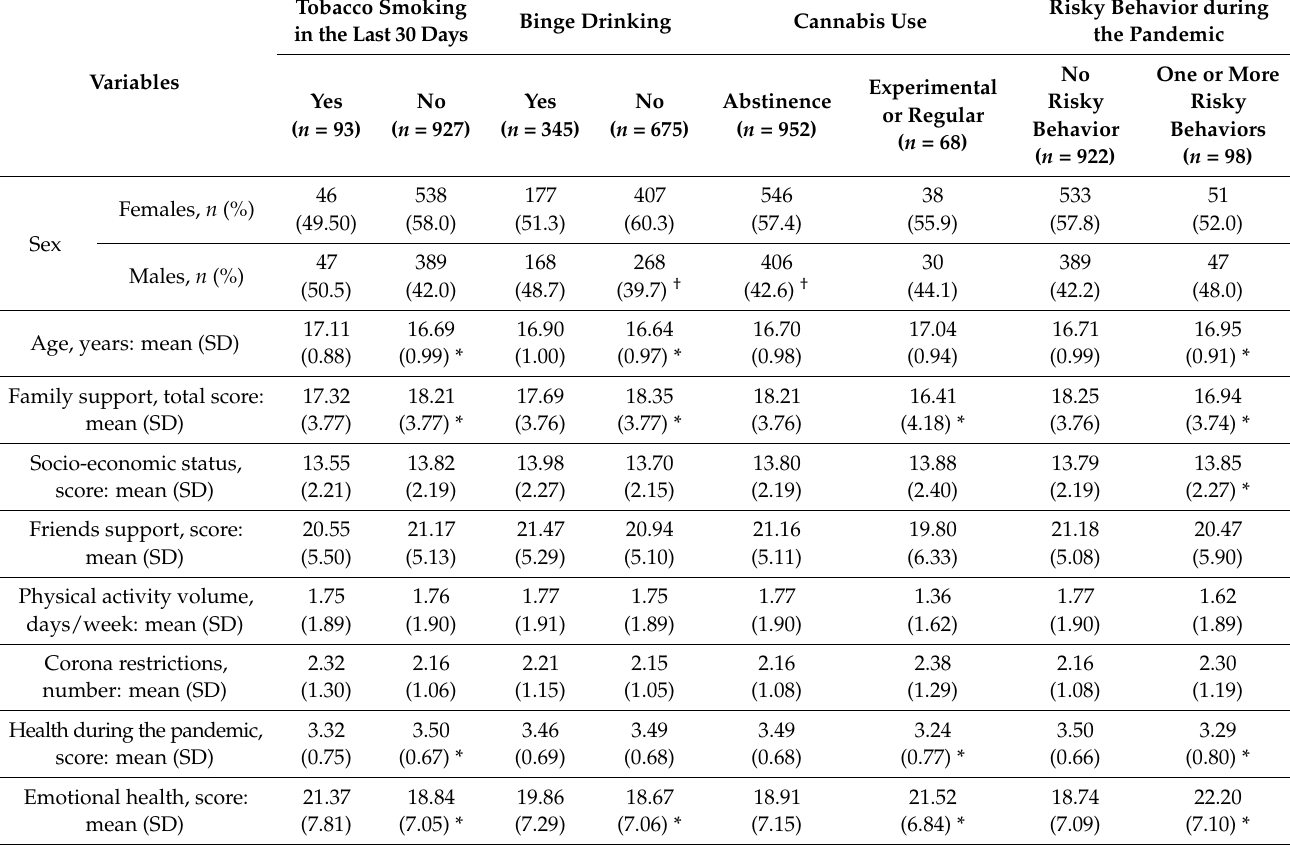
Table 5. Differences between participants presenting and not presenting risky behavior.